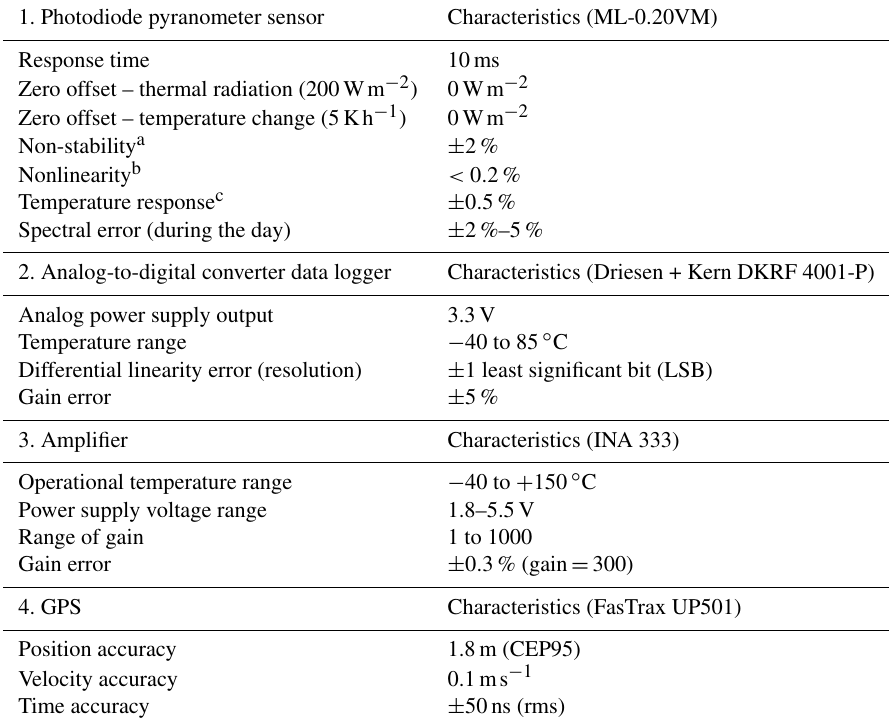
Table 1. Main components and specifications of a pyranometer